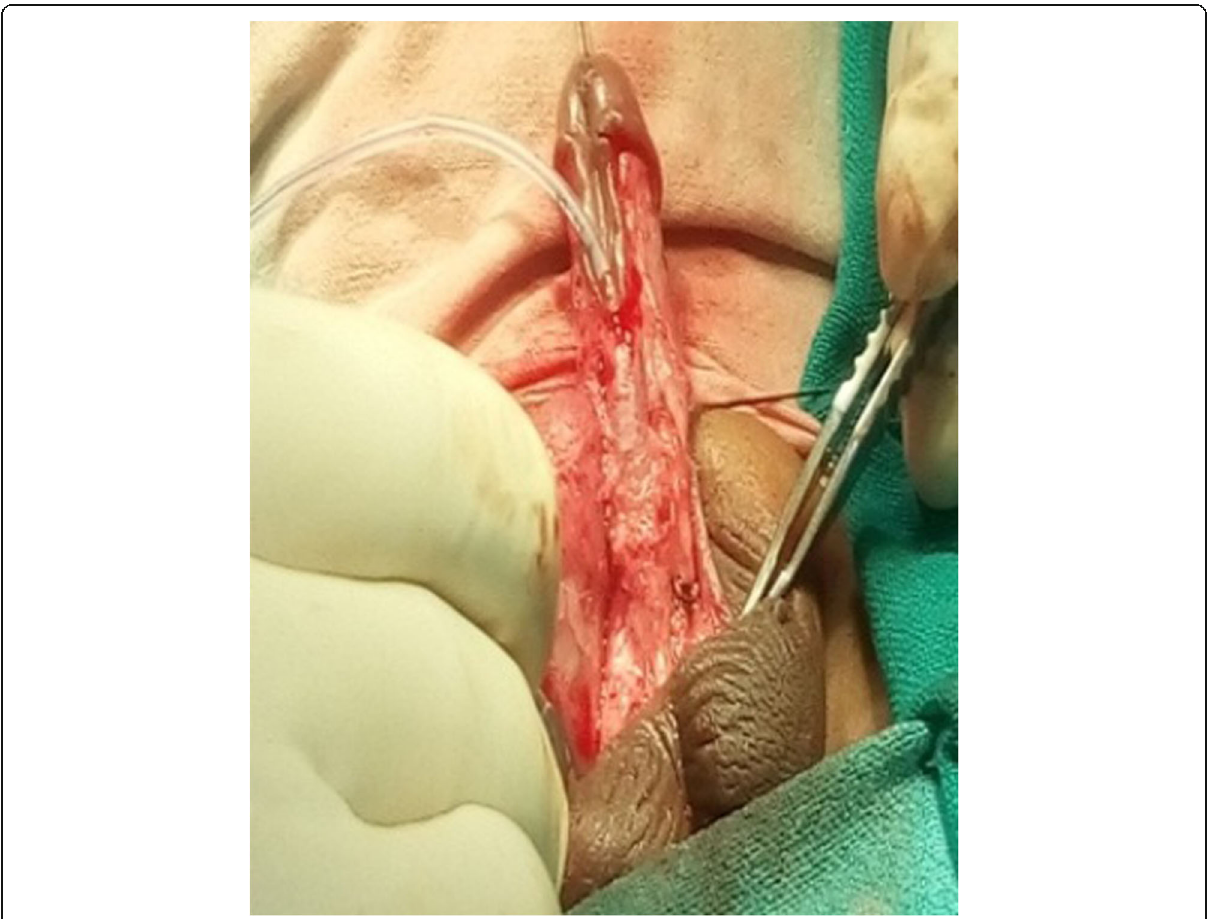
Fig. 3 Intraoperative picture of the same patient as in Fig. 2, after extensive ventral urethral detethering and penoscrotal realignment